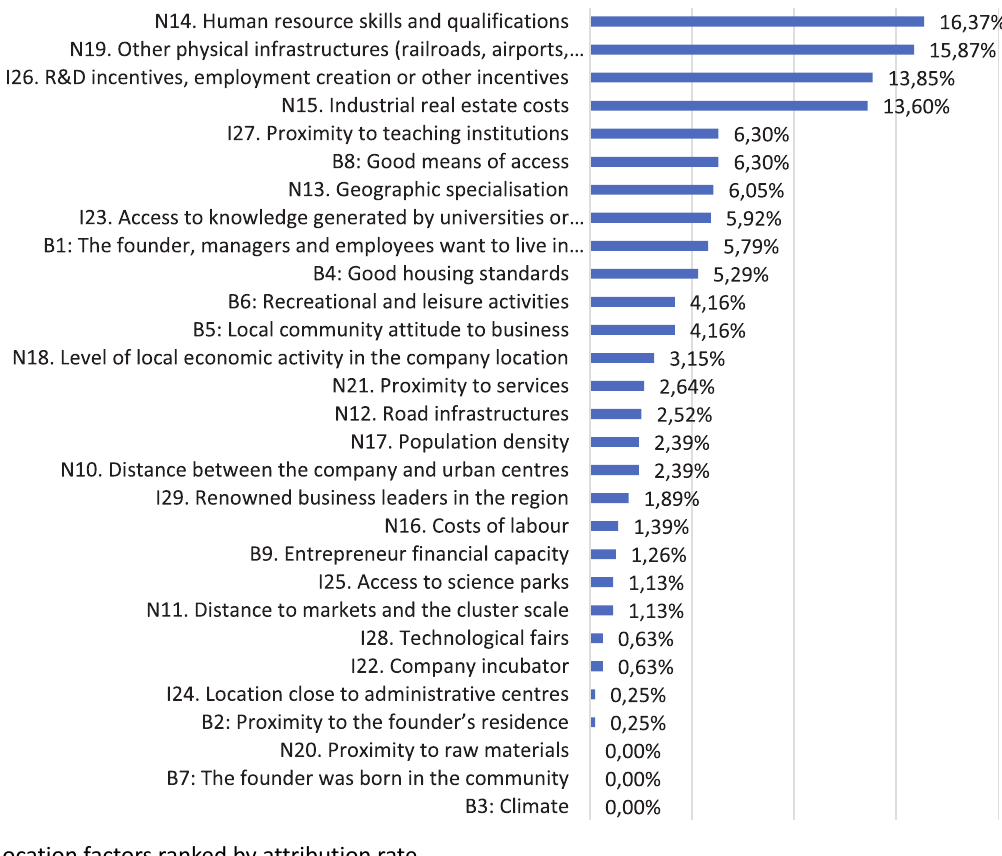
Figure 7 ranks the 29 factors by attribution rate. Four factors (N14. Human resource; N19. Infrastructure; I26. Incentives; and N15. Real Estate costs) are visibly set